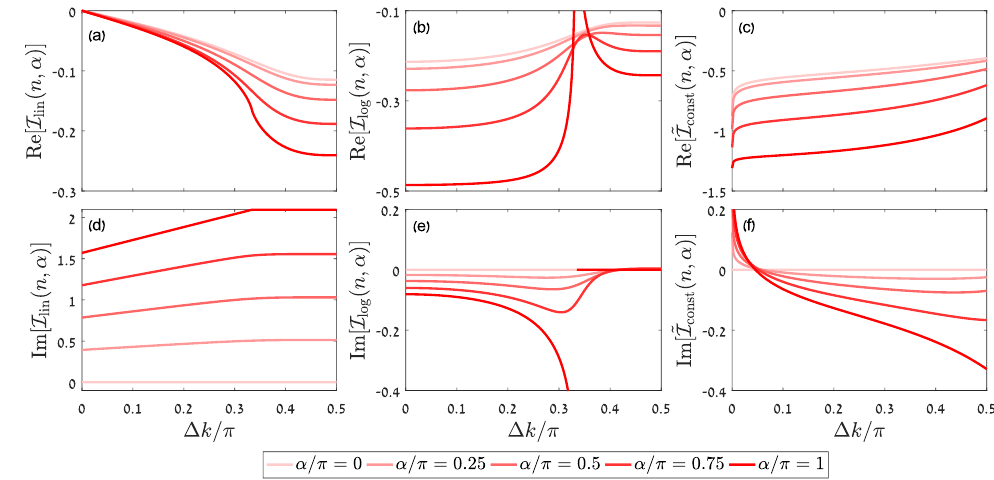
Figure 11: The single impurity model: Coefficients in the analytical asymptotic ex- ( α ) in Eq. (34), as a function of ∆ k = k pression for ln Z n values of α . The remaining parameters are set to n = 2, ε The top panels (a)–(c) show the real parts of the coefficients, and the bottom panels (d)–(f) show their imaginary parts. Panels (a) and (d) are for the coefficient I panels (b) and (e) are for I , and panels (c) and (f) are for ˜ I log